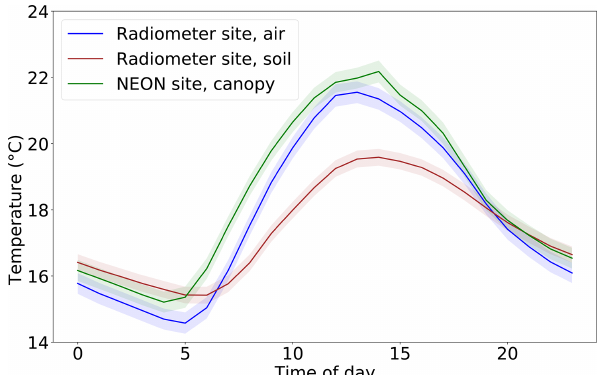
Figure 2. Average diurnal cycles of temperature from three sources over June through September 2019. Shaded area is a range of 1 stan- dard error. Air and soil temperatures each represent an average of two sensors. Time zone is local (eastern daylight